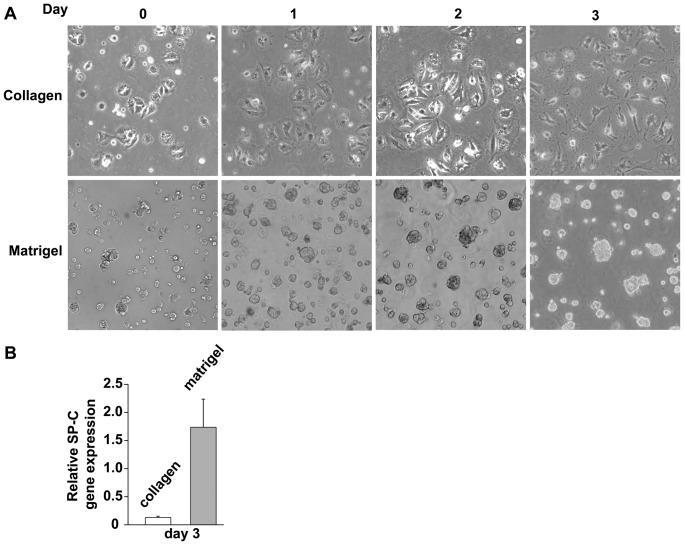

In vitro culture of adult human alveolar epithelial cells.(A) Human lung AT2 cell morphology changes more when cultured on rat-tail collagen-coated dishes than on Matrigel-coated dishes. Freshly-isolated human AT2 cells were seeded on collagen-coated or Matrigel-coated tissue culture dishes and photomicrographs were acquired after 12 hours (“Day 0”), 1, 2, and 3 days. Cells on collagen flattened and spread; cells on Matrigel remained cuboidal in shape and accumulated into enlarging “cysts”. Original magnification, 100X. (B) Gene expression analysis of Day 3 cells shows that SP-C, a marker of AT2 cells, is not expressed in cells cultured on collagen; however, its expression is retained on Matrigel.